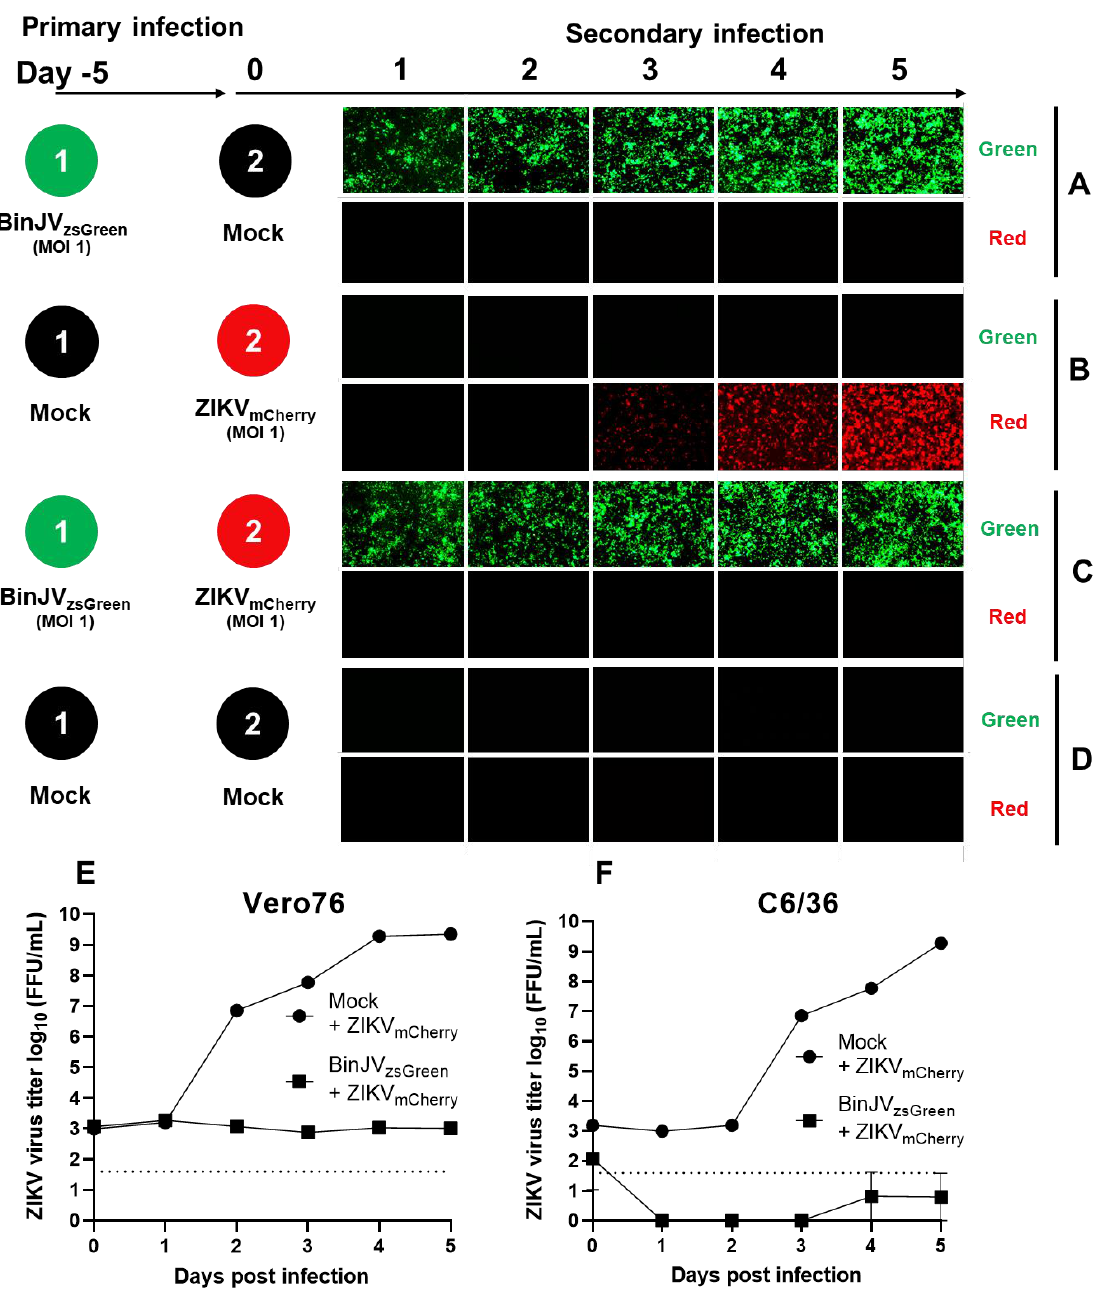
Figure 4. Superinfection exclusion of ZIKV by the insect-specific BinJV. Schematic showing the format of the infection trials and representative images of green and red fluorescence channels of C6/36 cells with ( A ) primary infections of BinJV zsGreen at − 5 days and mock (media only) secondary infection. ( B ) Mock primary infection at − 5 days and ZIKV mCherry secondary infection. ( C ) Primary infections of BinJV zsGreen at − 5 days, ZIKV mCherry secondary infection, and ( D ) mock (uninfected) primary and secondary timepoints. iPA assay of culture supernatant from the indicated time points of experiments ( B , C ) titred on Vero76 ( E ) and Ae. albopictus ( F ) cells. Values are the means from three replicates ± SEM. The dotted line is the limit of detection.